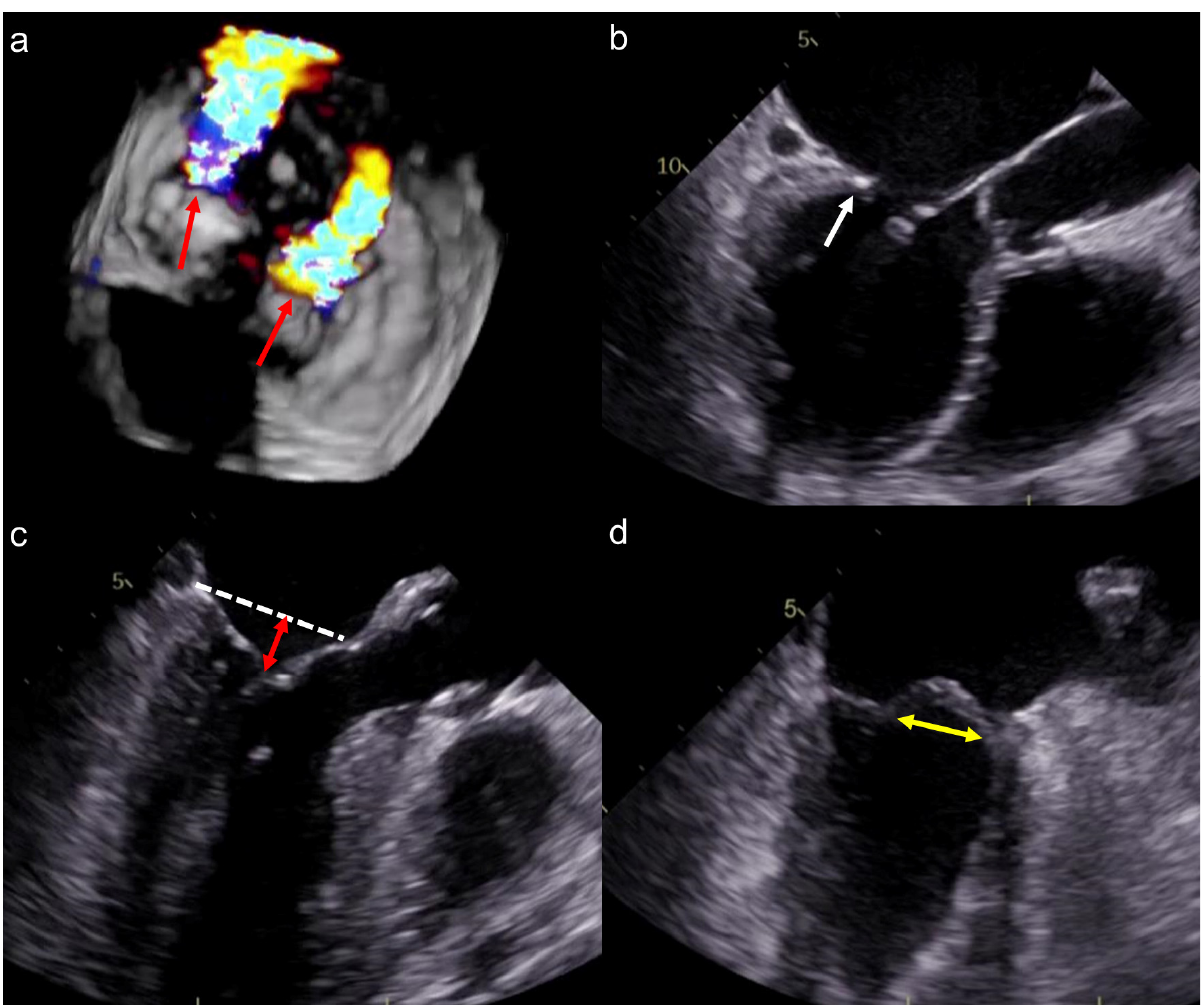
Figure 4. Representative cases of non-optimal valve morphologies for TEER. Red arrows indicate the MR jet in the lateral and medial segments ( a ). White arrow highlights the short length of the posterior leaflet with calcification ( b ). The red double-headed arrow depicts long coaptation height ( c ). The yellow double-headed arrow illustrates a long flail width ( d ). Abbreviations: MR, mitral regurgitation. Cardiac CT assessment was available in 20 out of 31 patients, of whom 13 (65.0%) were deemed to have non-eligible morphology for TMVR or annuloplasty technique.